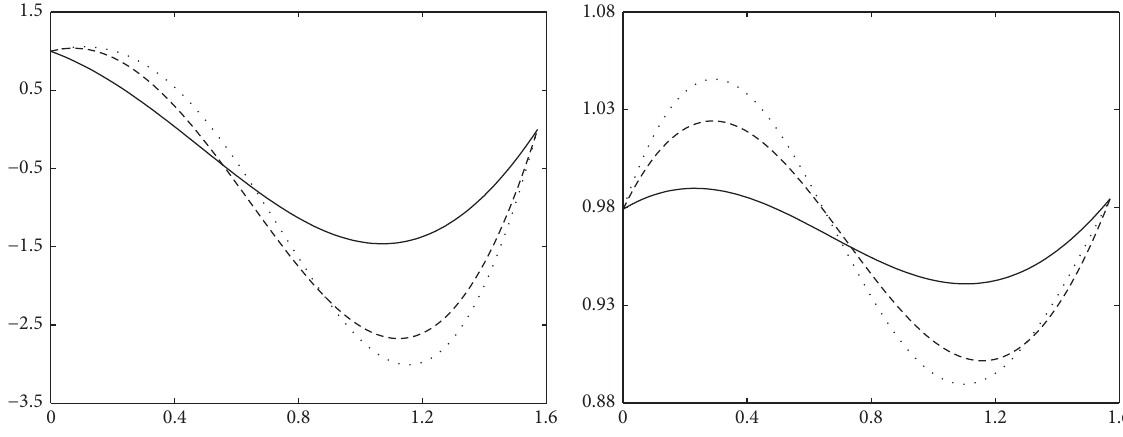
Figure 4: Quasi-interpolation for the functions 𝑓 1 and 𝑓 2